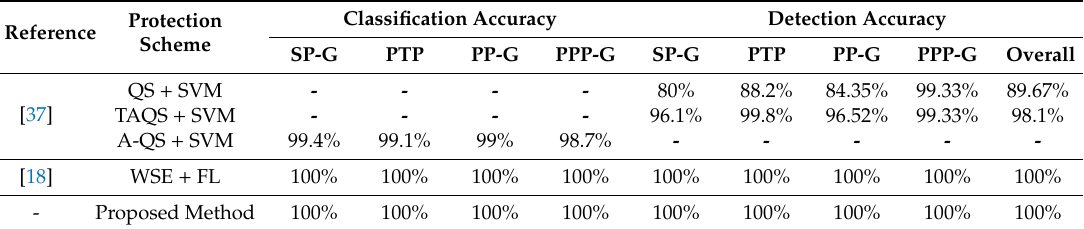
Table 5. Comparison results of di ff erent protection